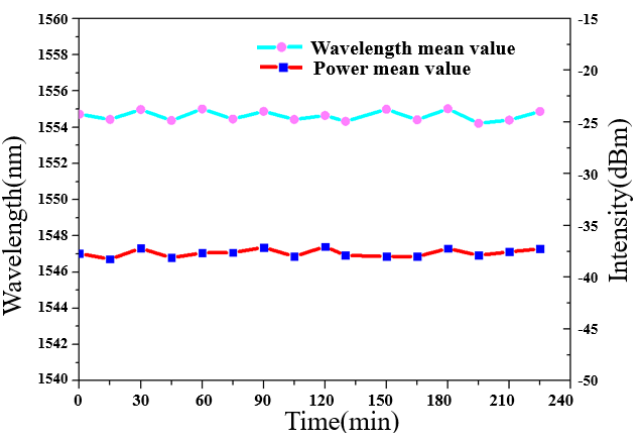
Figure 9. Test for time stability of wavelength shift and power fluctuation.